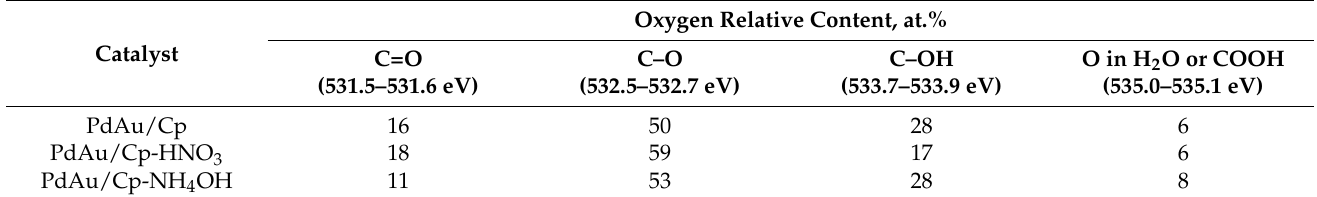
Table 7. Effect of modification of support on contribution of different electronic states of oxygen calculated according to